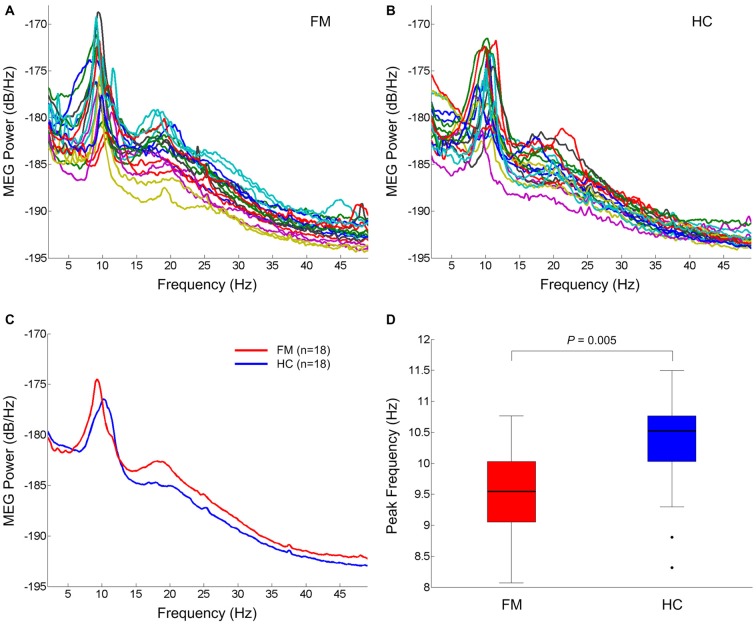
Resting state oscillatory brain activity. Superposition of individual mean power spectra of spontaneous brain activity recorded from all MEG gradiometer sensor pairs in FM patients (A) and HC subjects (B). Grand averaged power spectra of FM patients (red) and HC subjects (blue) (C). Box plots of the dominant peak frequency in the alpha band (D). On each box, the horizontal line is the median and the edges of the box are the 25th and 75th percentiles. Whiskers extend to the highest and lowest values within 1.5 times the interquartile range. The filled circles represent outliers. P value was determined by the two-tailed t-test for independent samples. FM, fibromyalgia; HC, healthy control.